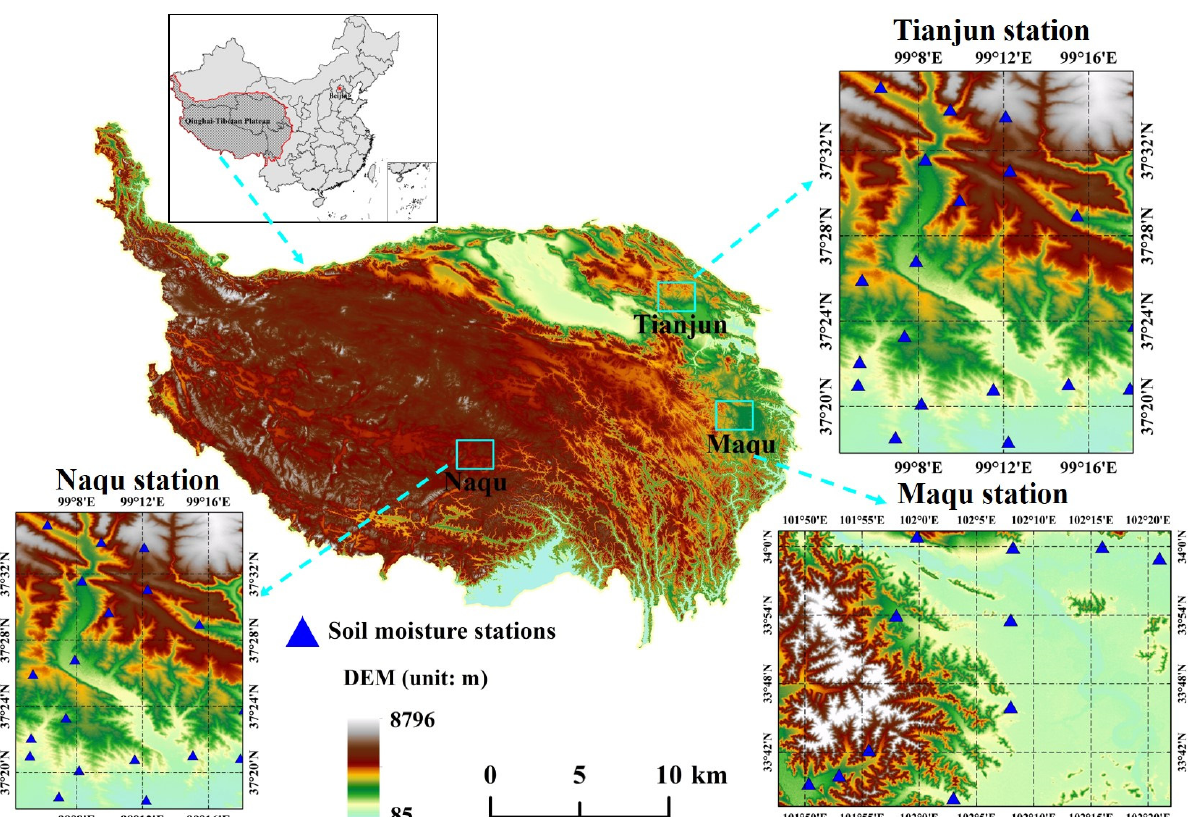
Figure 1. Locations of soil moisture monitoring networks on Qinghai–Tibetan Plateau: Naqu, Maqu, and Tianjun.